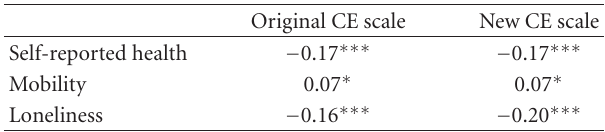
Table 4: Correlations of collective e ffi cacy scales with health and